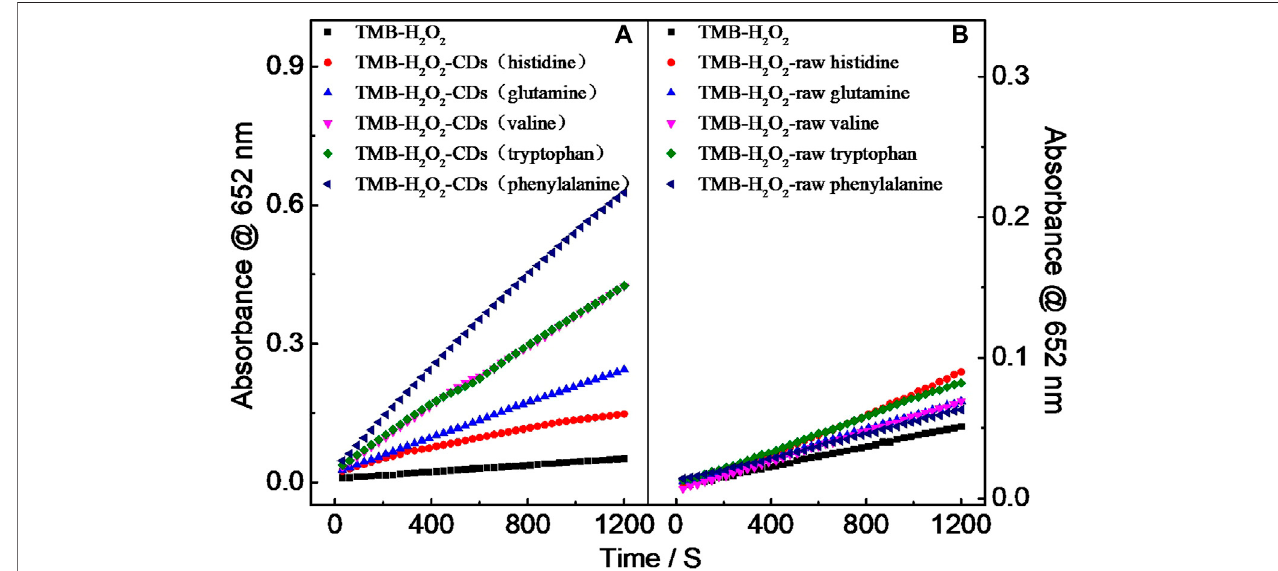
FIGURE 2 | Relationship curves of Ox TMB of absorbance at the 652-nm wavelength (A) and time in reaction systems (B) .